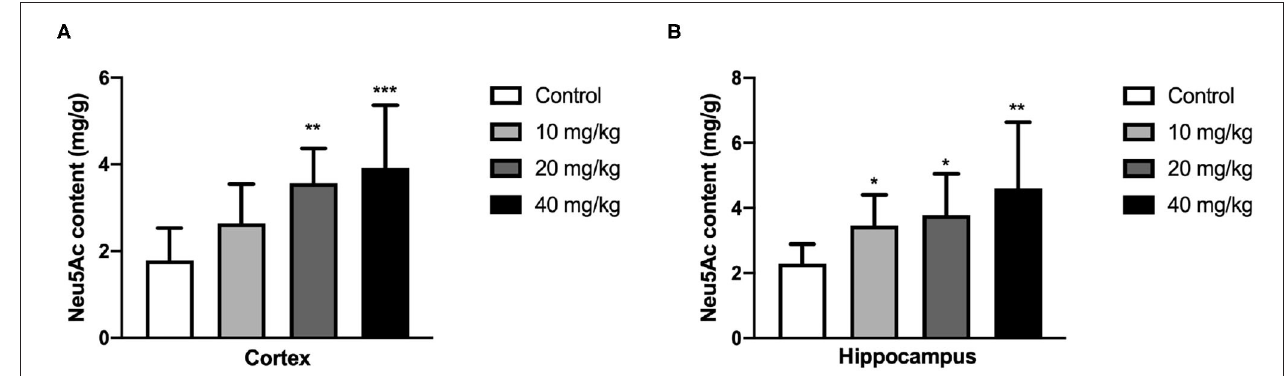
FIGURE 5 | Effects of perinatal Neu5Ac exposure on the brain Neu5Ac content in 100-day-old male rat offspring. Mother rats were treated with Neu5Ac [10, 20, or 40 mg/(kg · day)] or water (as control) from gestational day 15 to postnatal day 21. The results are expressed as the M ± SD ; n = 10 per group. * P < 0.05, ** P < 0.01, *** P < 0.001 indicates a significant difference compared with control-group